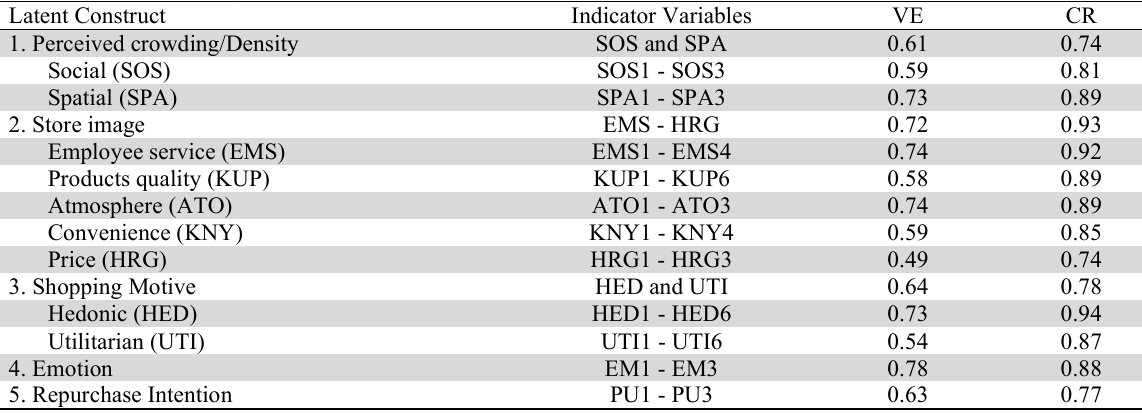
Latent construct reliability test